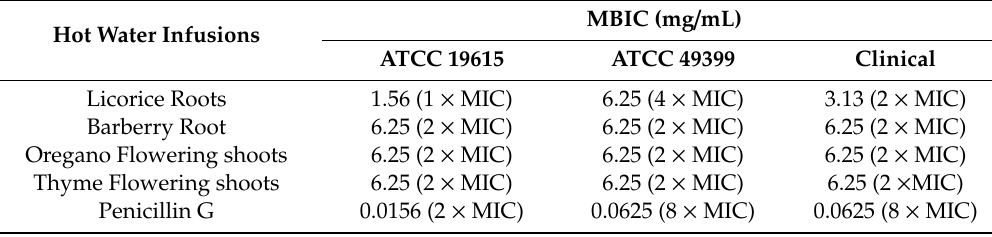
Table 3. Minimum biofilm inhibitory concentration (MBIC) against Streptococcus pyogenes strains. Hot Water Infusions Barberry Root Oregano Flowering shoots Thyme Flowering shoots